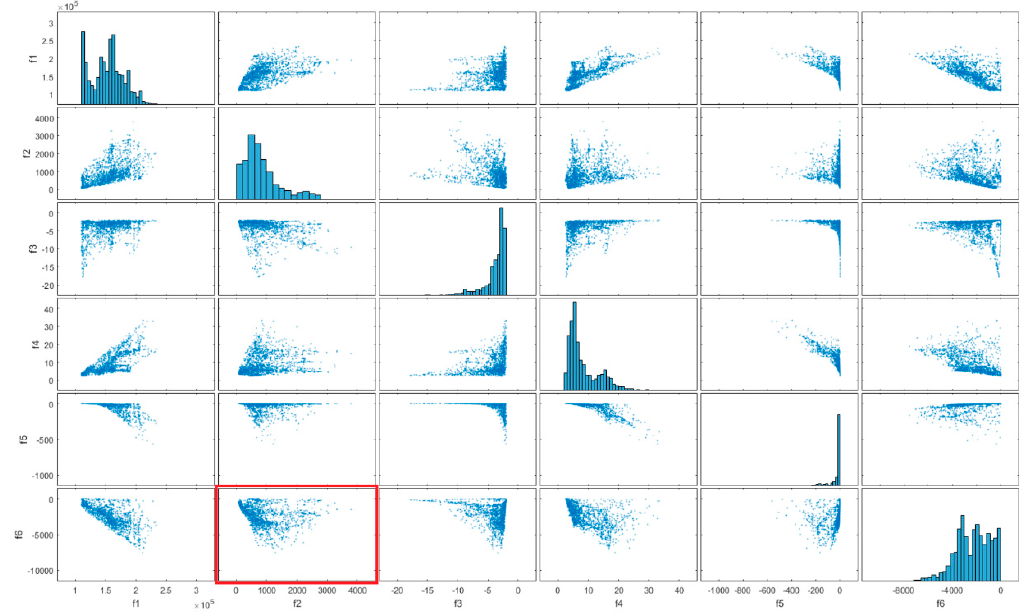
Figure 13. Set of Pareto optimal solutions presented in the form of scatter matrix plot for the 2nd variant of optimization task.